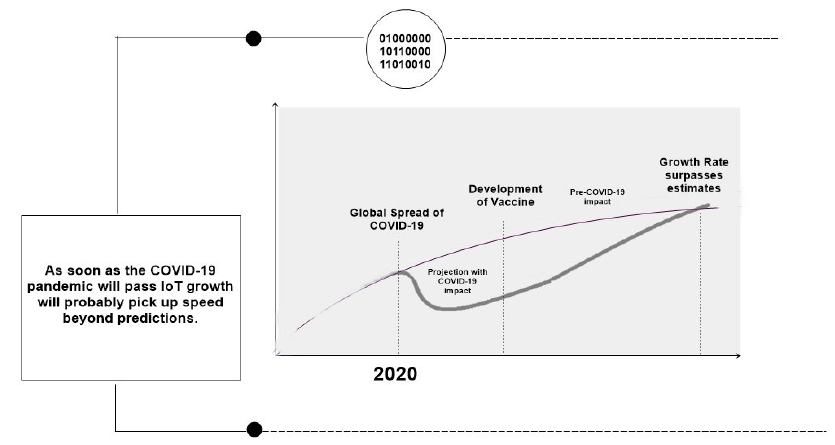
Figure 1. Growth in IoT in the COVID ‐ 19 pandemic [6].